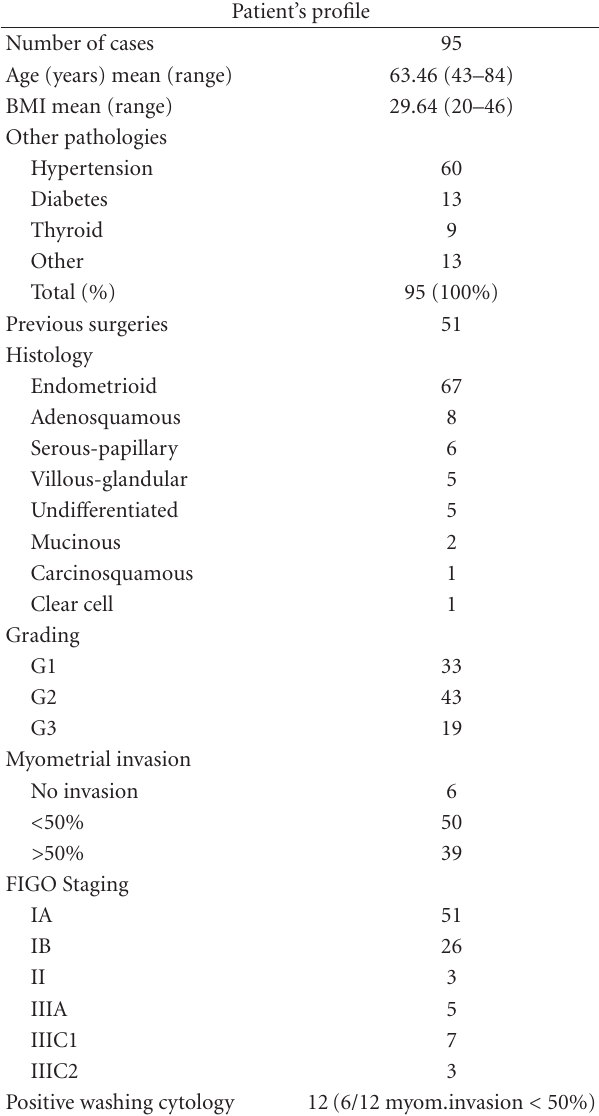
Table 1: Patients characteristics.